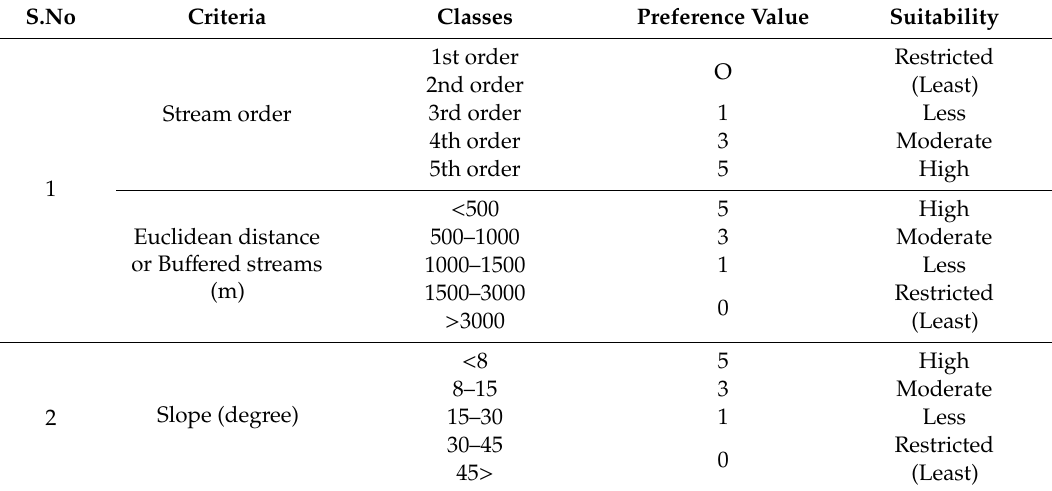
Table 1. Reclassified layers and their preference value.